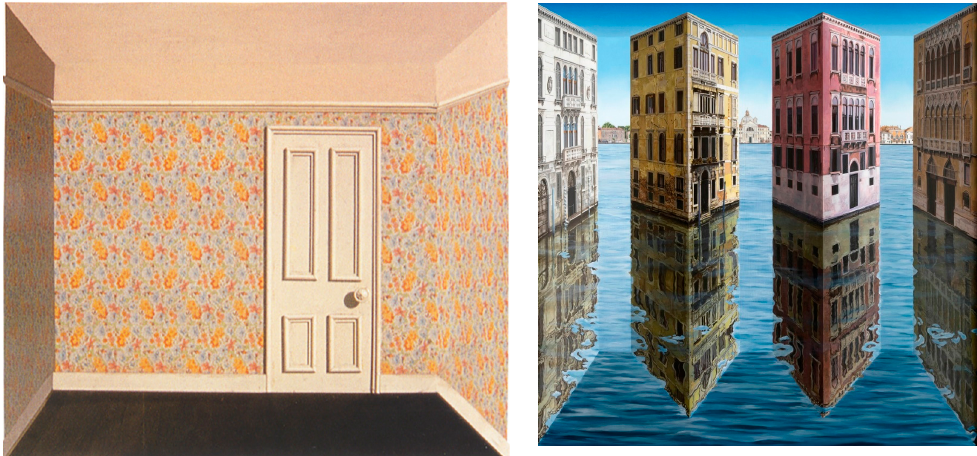
Figure 1. Left panel: “Sticking-out Room” (1964). It must be pointed that this “room” scene is painted on a 3D truncated pyramid that juts toward the viewer. Specifically, what appears to be the far wall with a door is physically closer to the viewer than the outer edges of the floor, walls, and ceiling. Right panel: “Real Reflections” (2017).